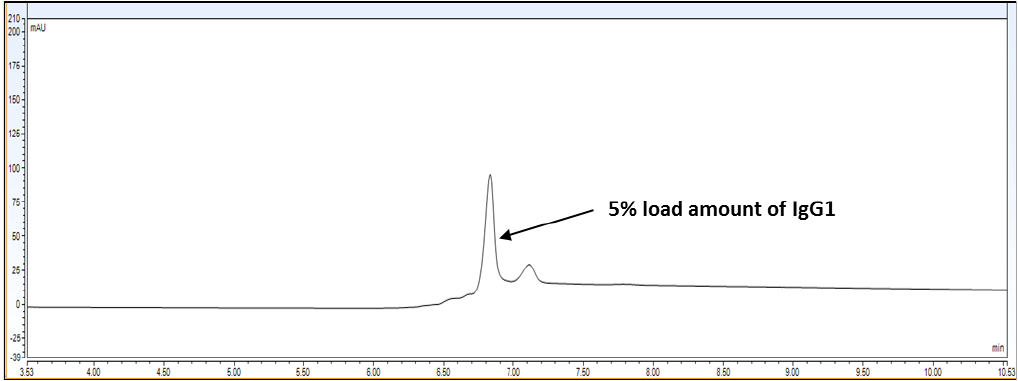
Figure 5. Representative chromatogram for IgG1 sample loading of 5%, i.e., 0.15 mg/mL from 100% standard injection amount, i.e., 3.0 mg/mL for LOD calculation.